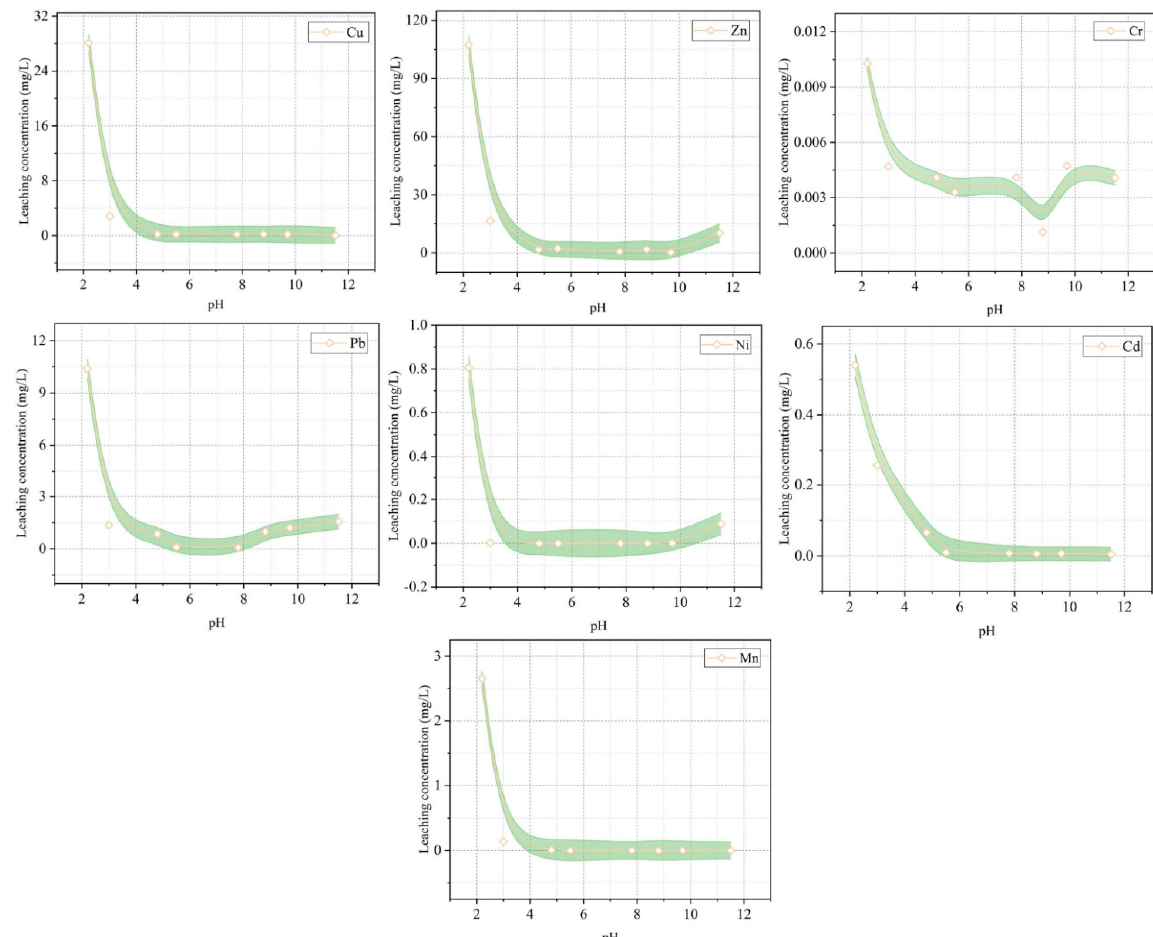
Figure 18. Heavy metals leaching from CS at different pH values [112].